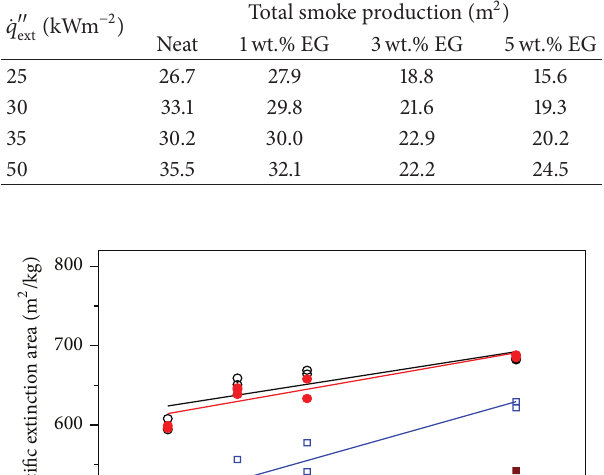
Table 7: Activation energies ( 𝐸 𝑎 ) and preexponential ( 𝑘 𝑜 ) terms of the epoxy-EG composite